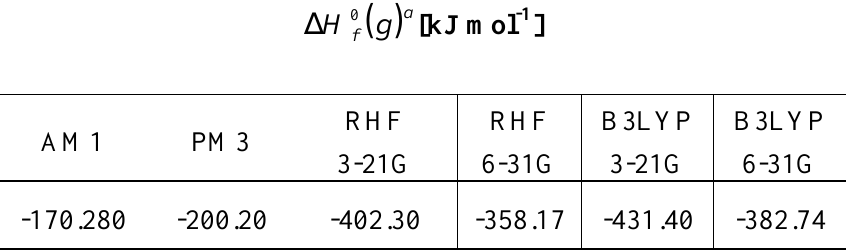
Table 4 . Enthalpy of formation of